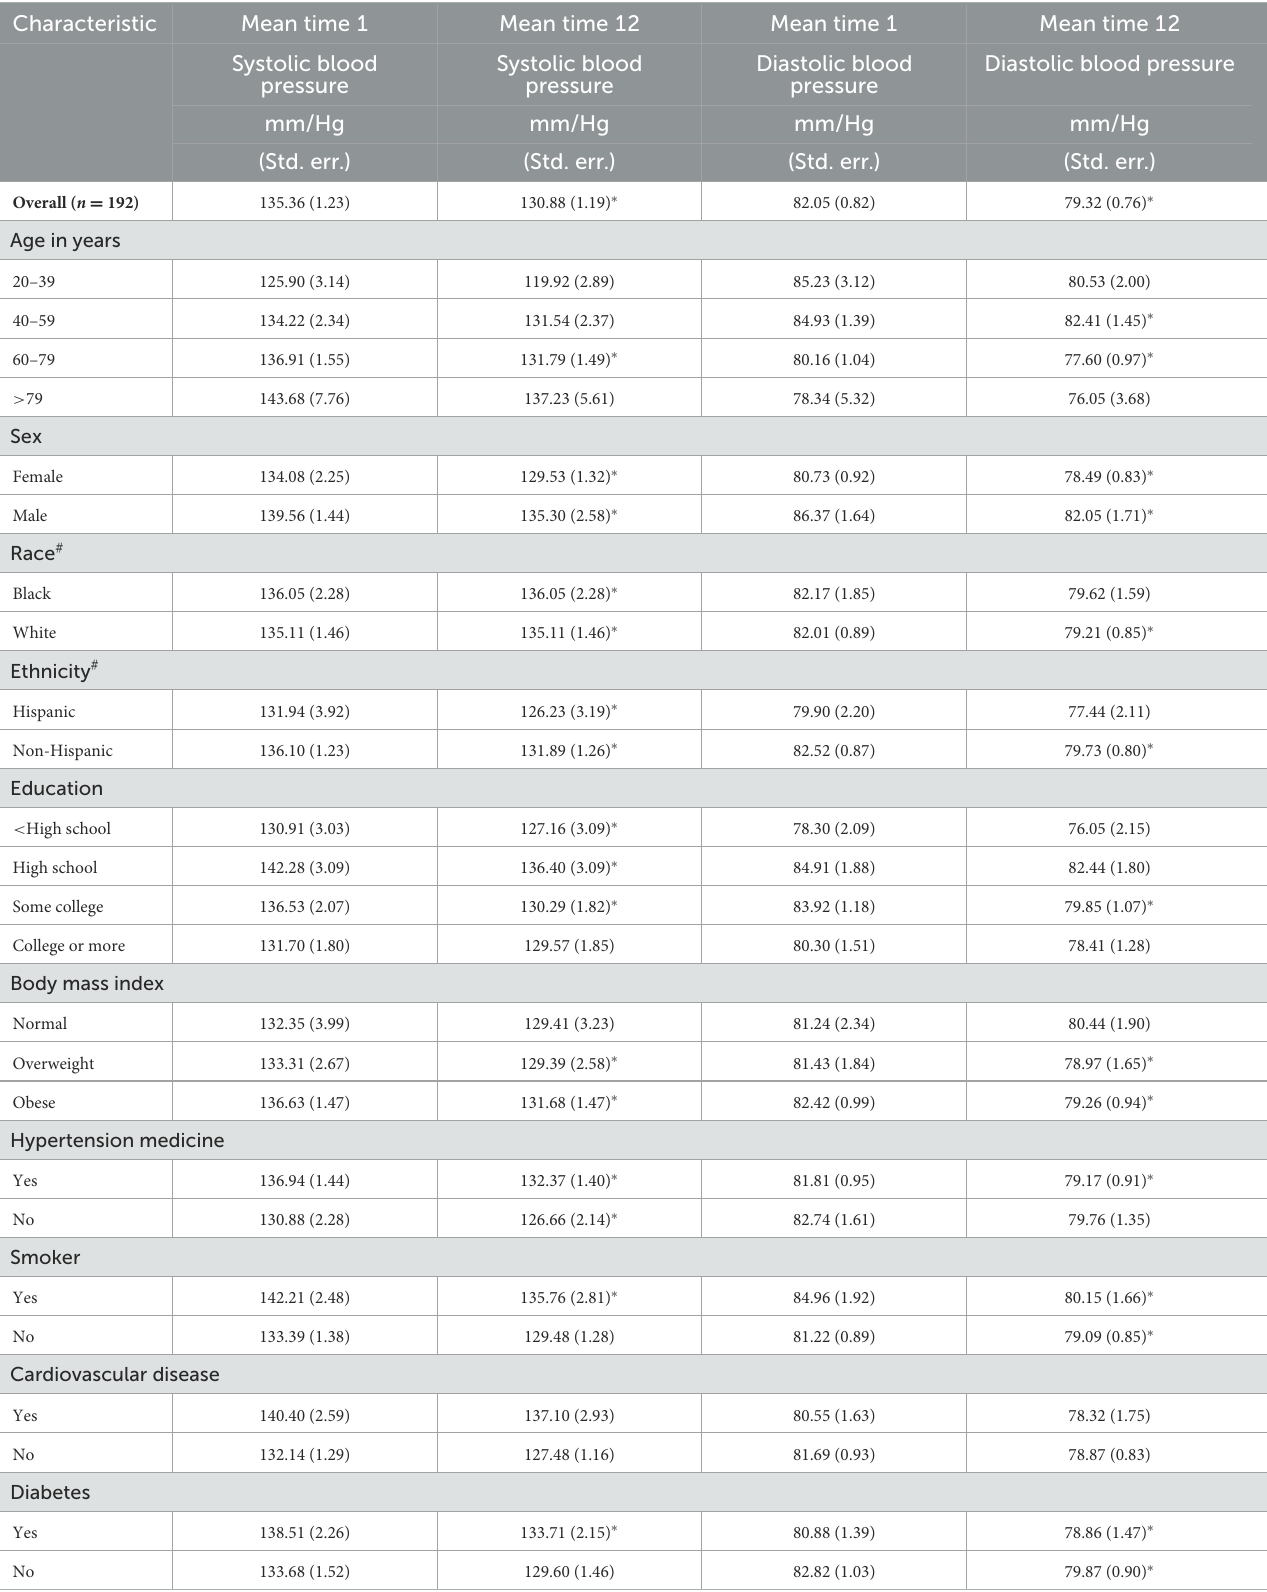
TABLE 4 Change in mean systolic and diastolic blood pressure mm/Hgb time 1 to time 12.